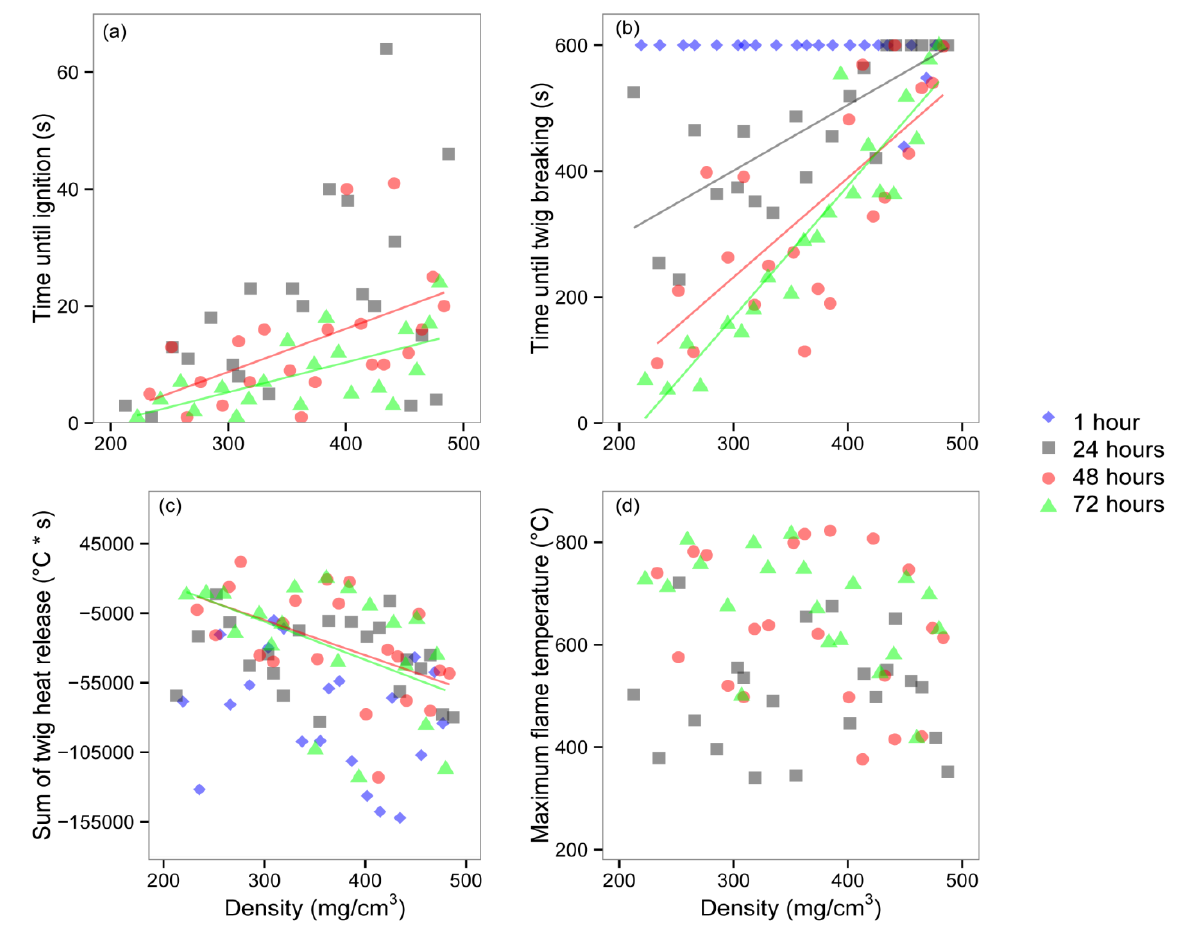
Figure 5. Interactive effects of density and water dynamics on flammability variables of Quercus robur twigs: ( a ) time until ignition, ( b ) time until twig breaking, ( c ) sum of twig heat release, and ( d ) maximum flame temperature. Points with different shapes and colours represent different drying periods of Quercus robur twigs before burning; Only significant relationships within a certain drying period are shown as regression lines (Table